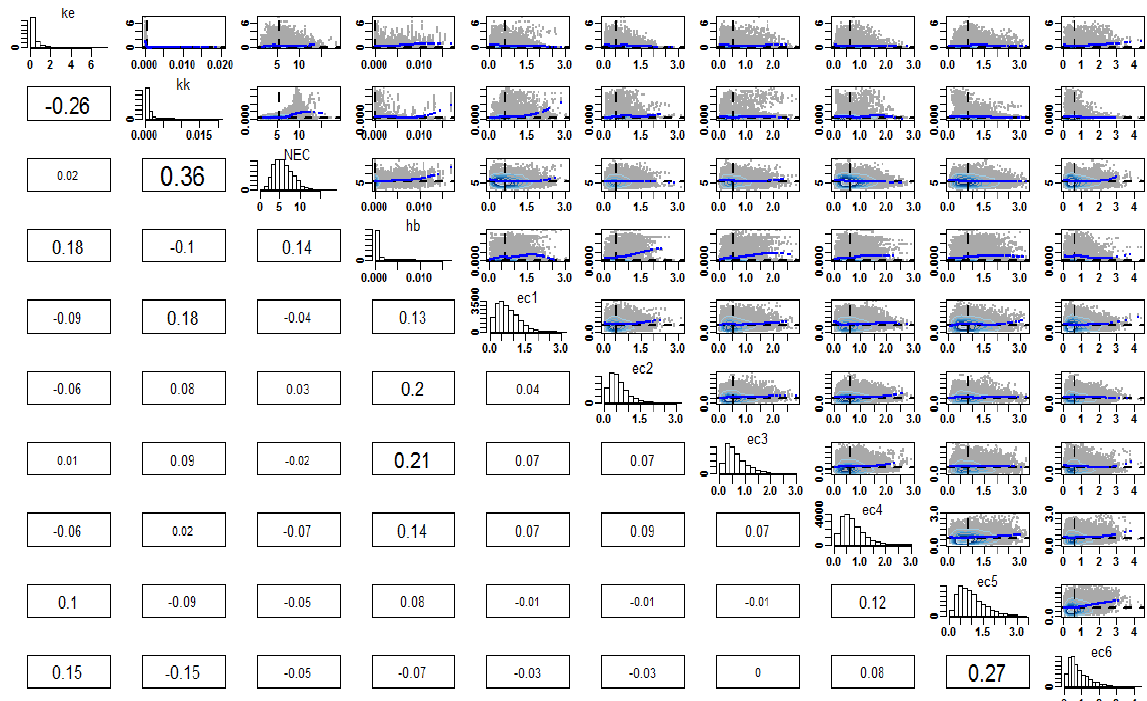
Fig. 2. Parameter correlations